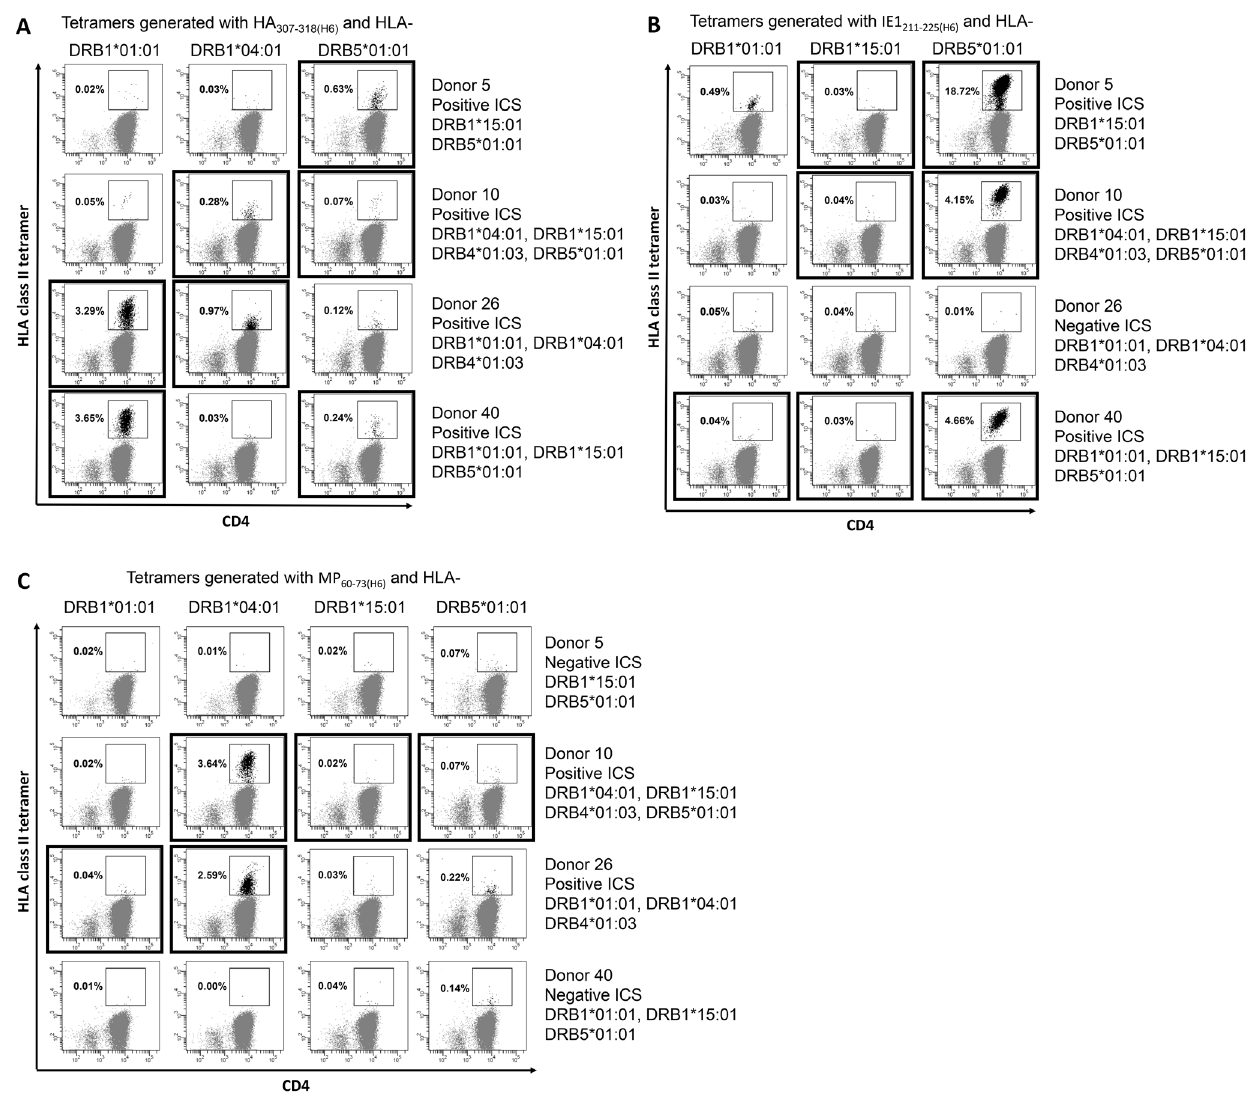
Figure 3. MHC class II tetramer stainings of Ag-specific CD4 + T cells. PBMCs from four donors were in vitro cultured with a mix of three different peptides